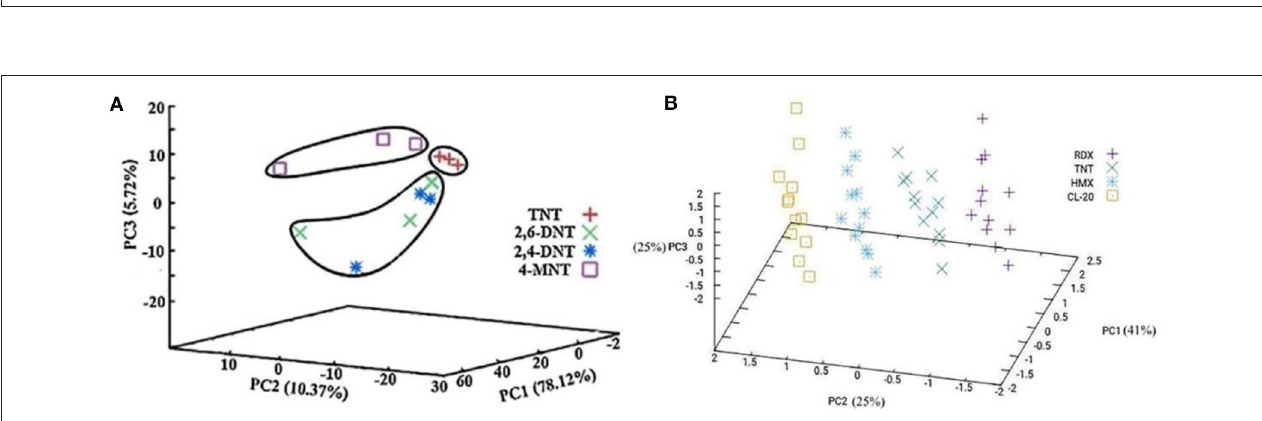
FIGURE 5 | Principal component analysis score plot for (A) TNT, 2,6-DNT, 2,4-DNT, and 4-MNT (reprinted with the permission of Lu et al., 2017; Copyright 2017 Elsevier); (B) RDX, TNT, HMX, and CL-20 of the first three principal components (reprinted with the permission of Fan et al., 2020; Copyright 2020 Elsevier).